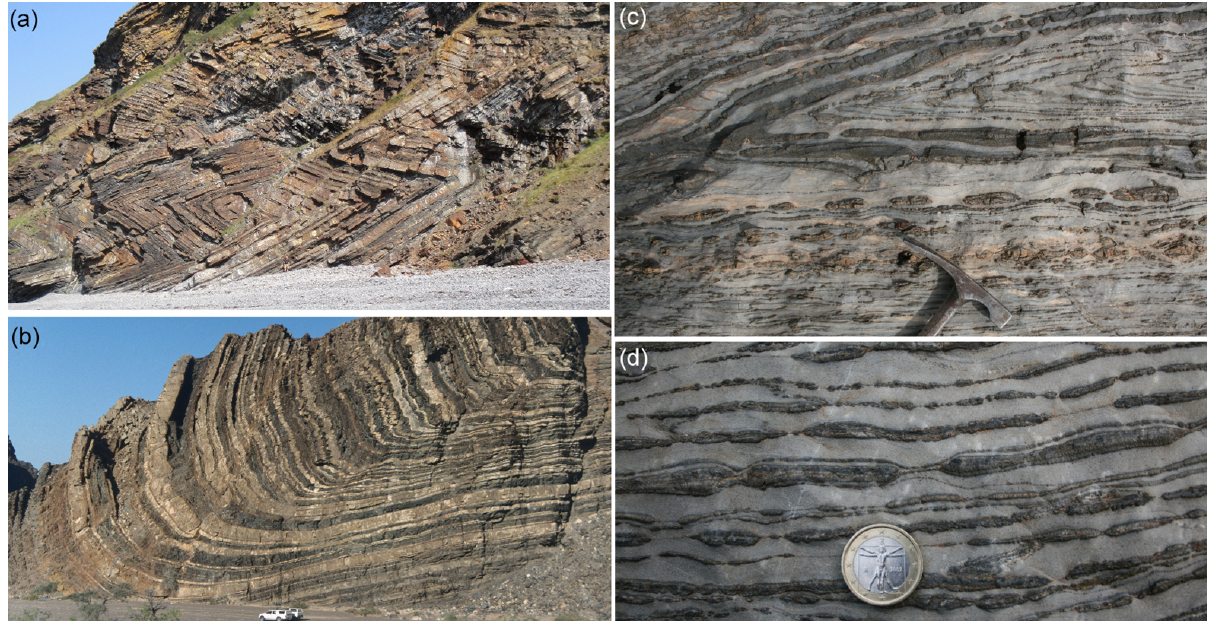
Figure 5. Multilayer folds (a, b) , multilayer folds with boudins (c) and multilayer pinch-and-swell with boudins (d) . (a) Folded carboniferous sandstones and shales at Millook Haven, Cornwall, England. (b) Multilayer folds in alternating turbiditic sandstone and shale layers, lower Rhino Wash, Ugab region, northern Namibia. (c) Folded and extended layers of calc-silicate in marble, Monte Frerone, Adamello region, Italy. (d) Extended multilayer of calc-silicate in marble around Monte Frerone, Adamello region, Italy. Photographs (a) , (c) and (d) by S. Schmalholz and (b) by N.